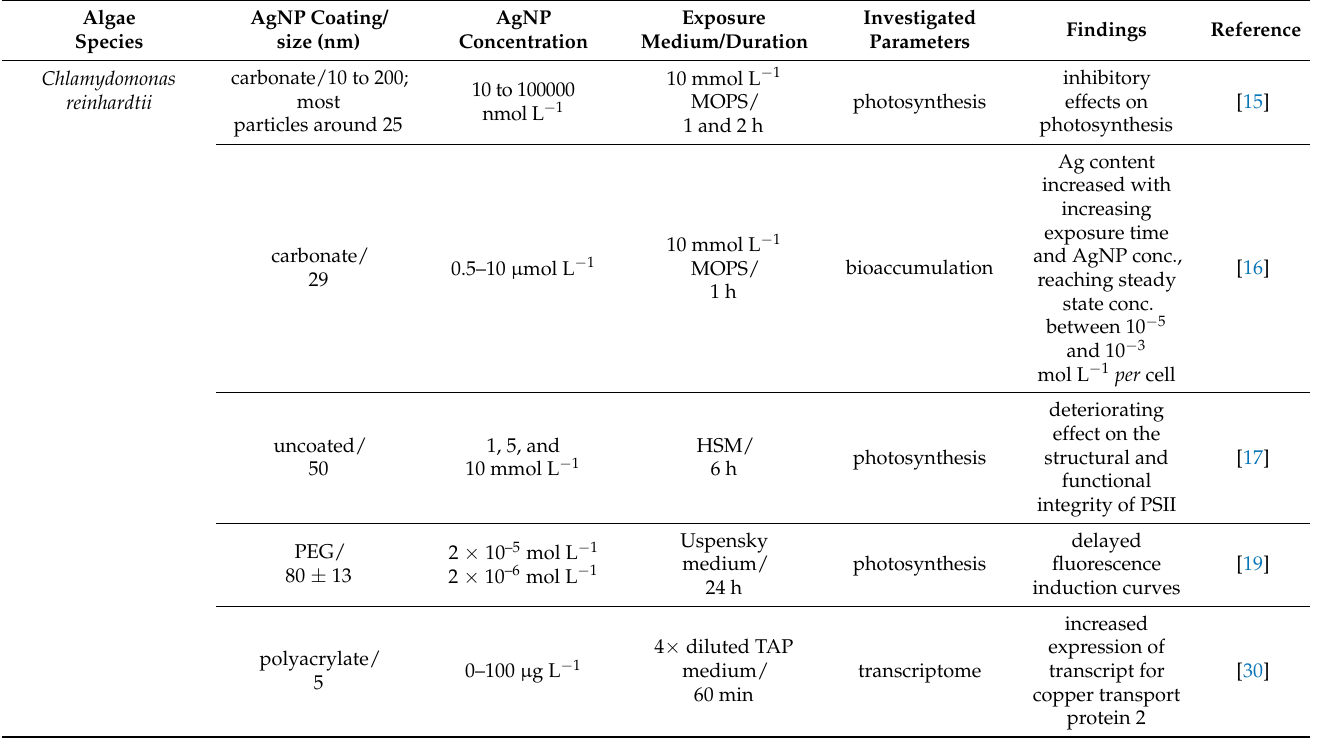
Table 1. Effects of differently coated AgNPs on fresh water green algae. Studies are listed chronologi- cally according to the number of studies performed on particular algal